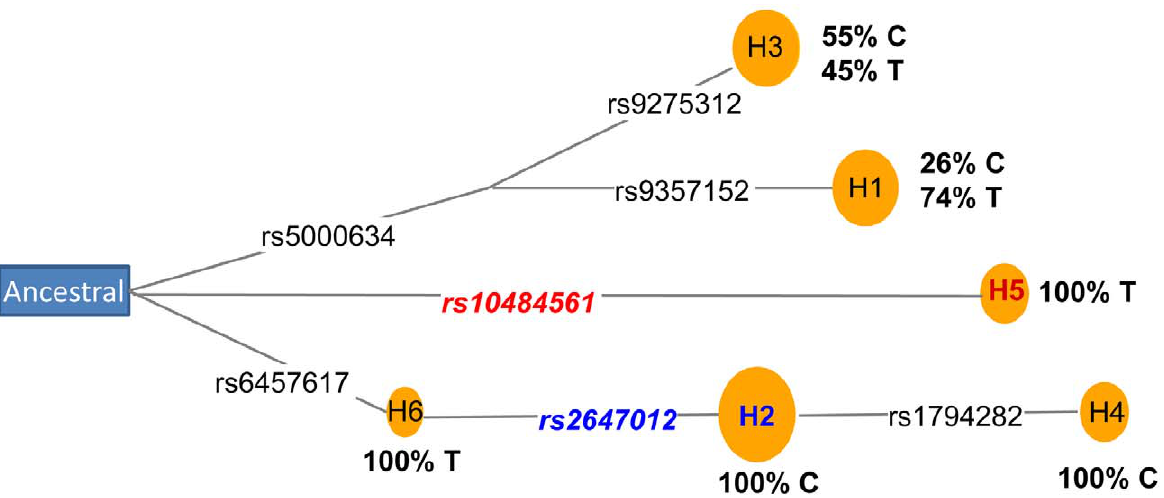
Figure 4. Coalescence analysis of rs2647012 and rs10484561. Median-joining network [14] of haplotypes constructed using seven SNPs (Table S9). Circles represent haplotypes with area proportional to their frequency. SNPs are shown on the links (black lines). SNPs and haplotypes associated with increased or decreased FL risk are labeled in red or blue, respectively. The percentage of alleles of the imputed SNP rs9378212 (C/T) phased on each haplotype are shown in bold.